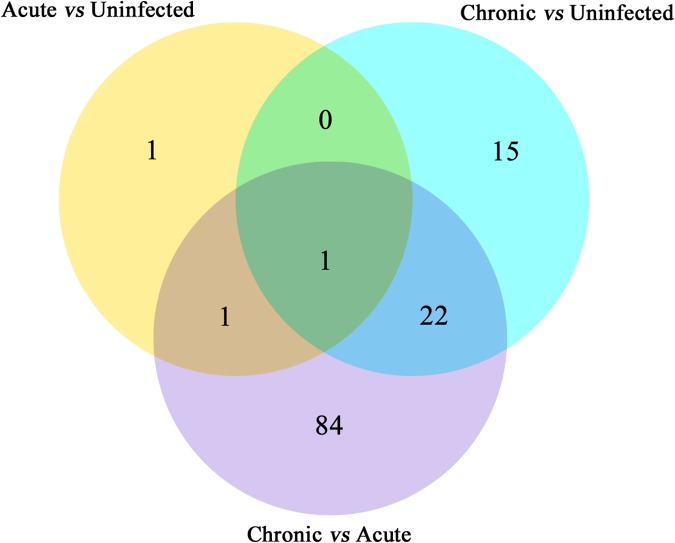
Venn diagram showing the number of commonly expressed and specifically expressed miRNAs between mouse groups. The miRNAs that are significant and specific for in mice with acute infection vs. healthy control are shown in the yellow circle. The light blue circle represents the miRNA markers that discriminate chronically infected mice and control mice, while the purple circle stands for the miRNA markers that permit a distinction of chronically vs. acutely infected mice.